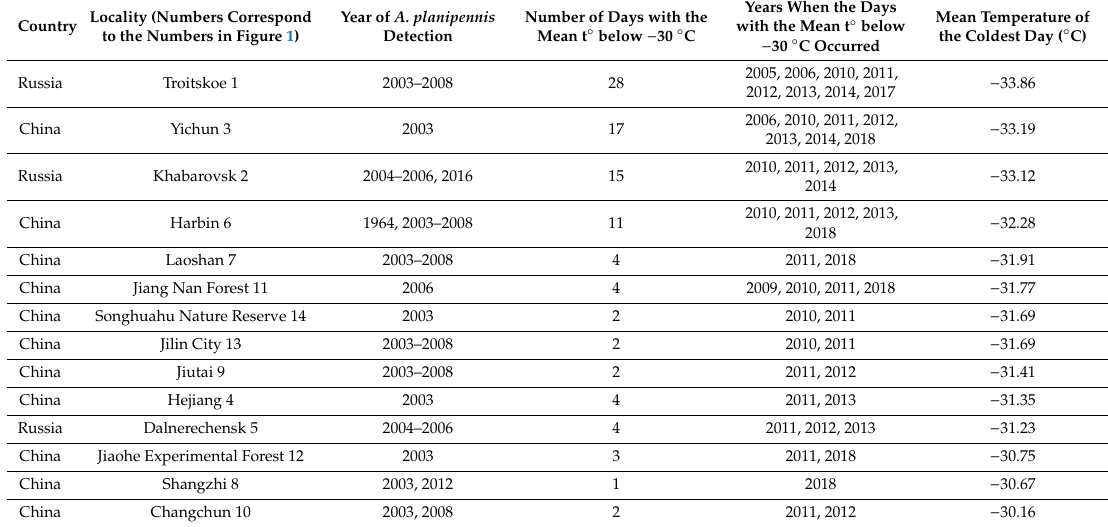
Table 1. Temperatures below − 30 ◦ C occurred from 2003–2019 in the localities where A. planipennis populations were recorded during this period